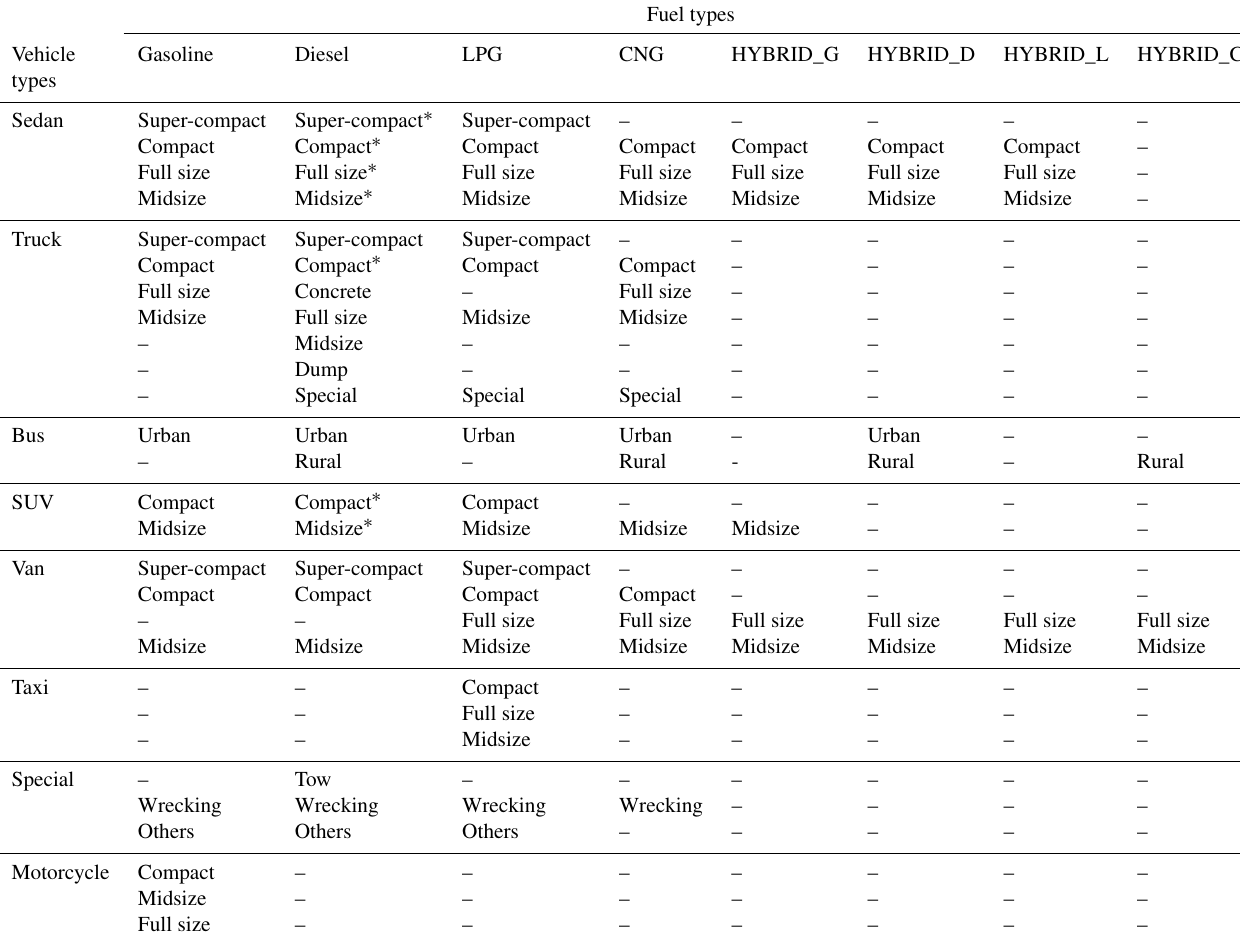
Table A1. The vehicle types classified by fuel type, vehicle body type, and engine size. The emission factors of the diesel vehicles indicated with an asterisk ( ∗ ) are dependent on the ambient temperature ( T